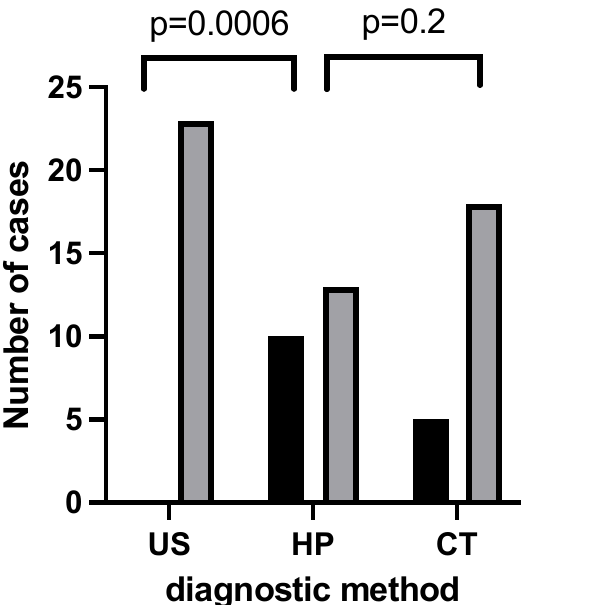
Figure 11. Renal capsule invasion evaluation by US/CT comparative to histopathological examina- tion.